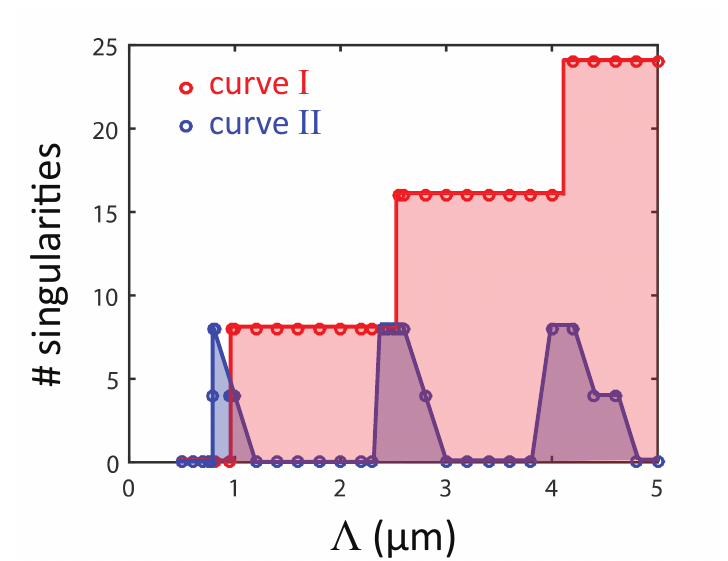
Figure 3. Number of C-points in our field of view, for the plasmonic system introduced in Figure 2, as a function of Λ , showing clear plateaus of multiples of eight. Both the C-points found along curve I are shown (in red), as are those along curve II (in